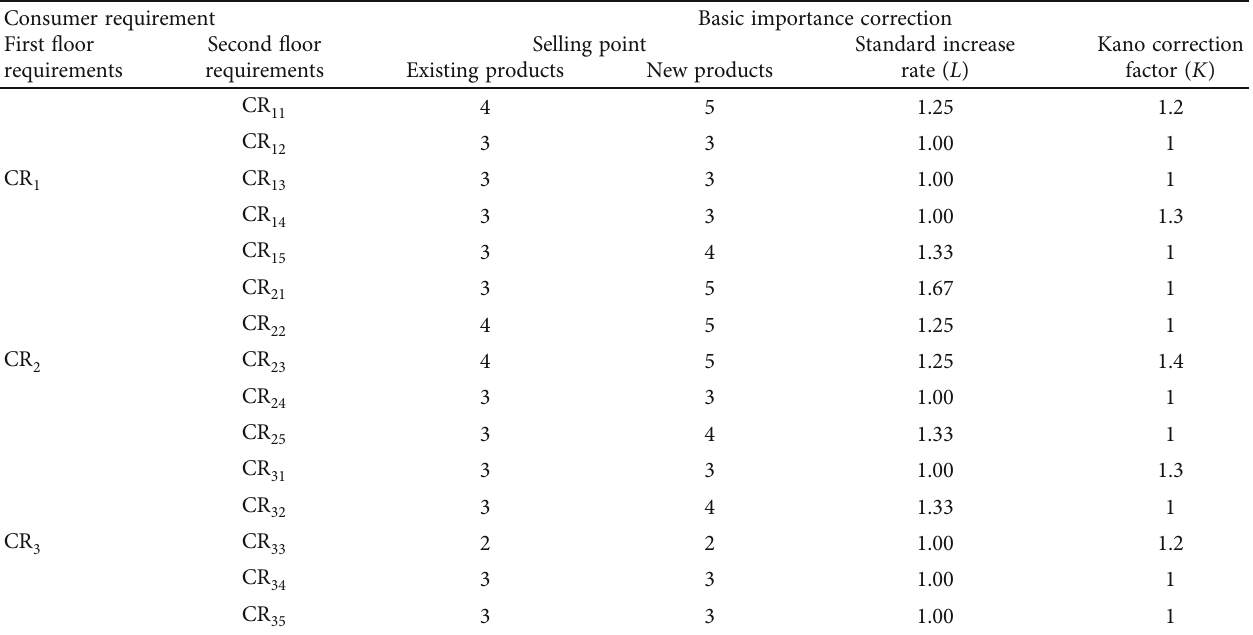
Table 8: Market competitive advantages of each